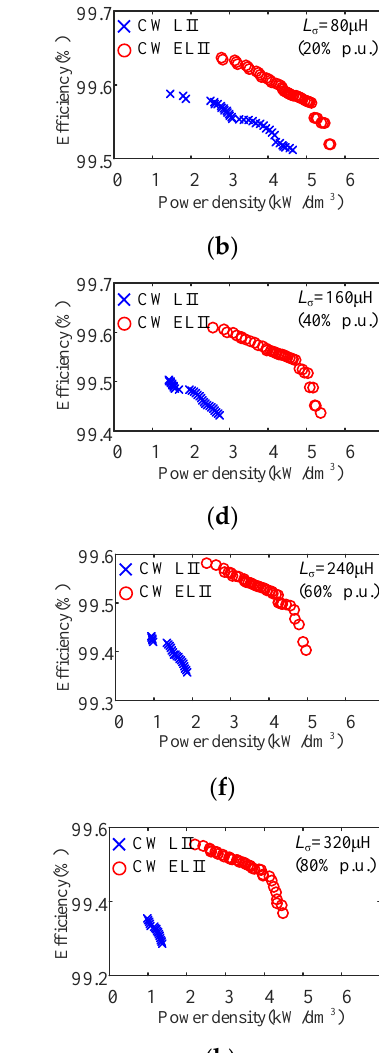
( b ) Figure 22. Comparison of solutions for different inductance requirements. ( a ) Max power density; ( b ) efficiencies. While keeping other parameters unchanged, the rated current in the design input is changed to analyze the influence of the power on the design result. In all groups, the leak- age inductance in per-unit is 50%. Figure 23 shows the comparison of the Pareto fronts of CW ELII MFT designs with different power requirements. As the power increases, it is easier to achieve higher power densities. A possible reason is that the insulation distance in the MFT is a fixed parameter under the same insulation requirement. With the increase of rated current (80 kW to 280 kW), the proportion of wind- ings in the core window increases and the proportion of insulating space decreases, which makes the MFT power density increase. When the rated current is large enough (280 kW and 320 kW), the proportion of insulating space is small, and this effect is no longer obvi- ous.